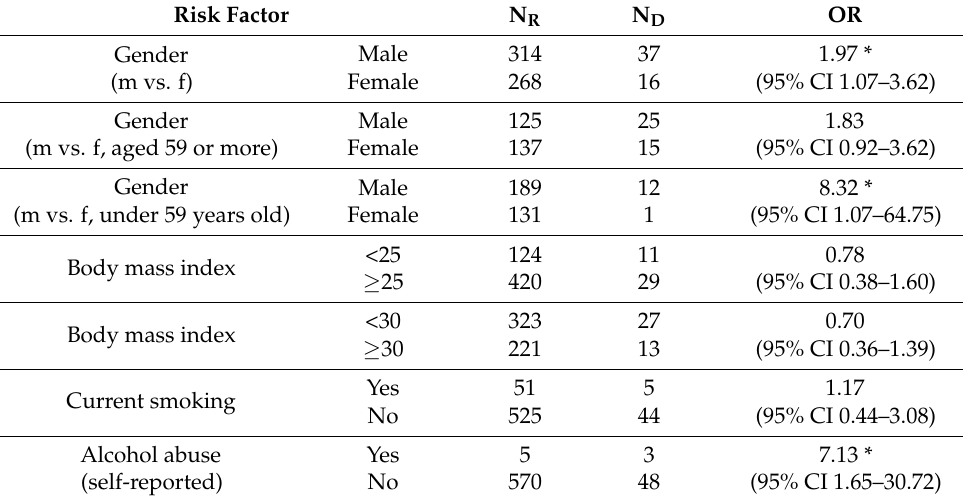
Table 2. Summary of key findings among epidemiological risk